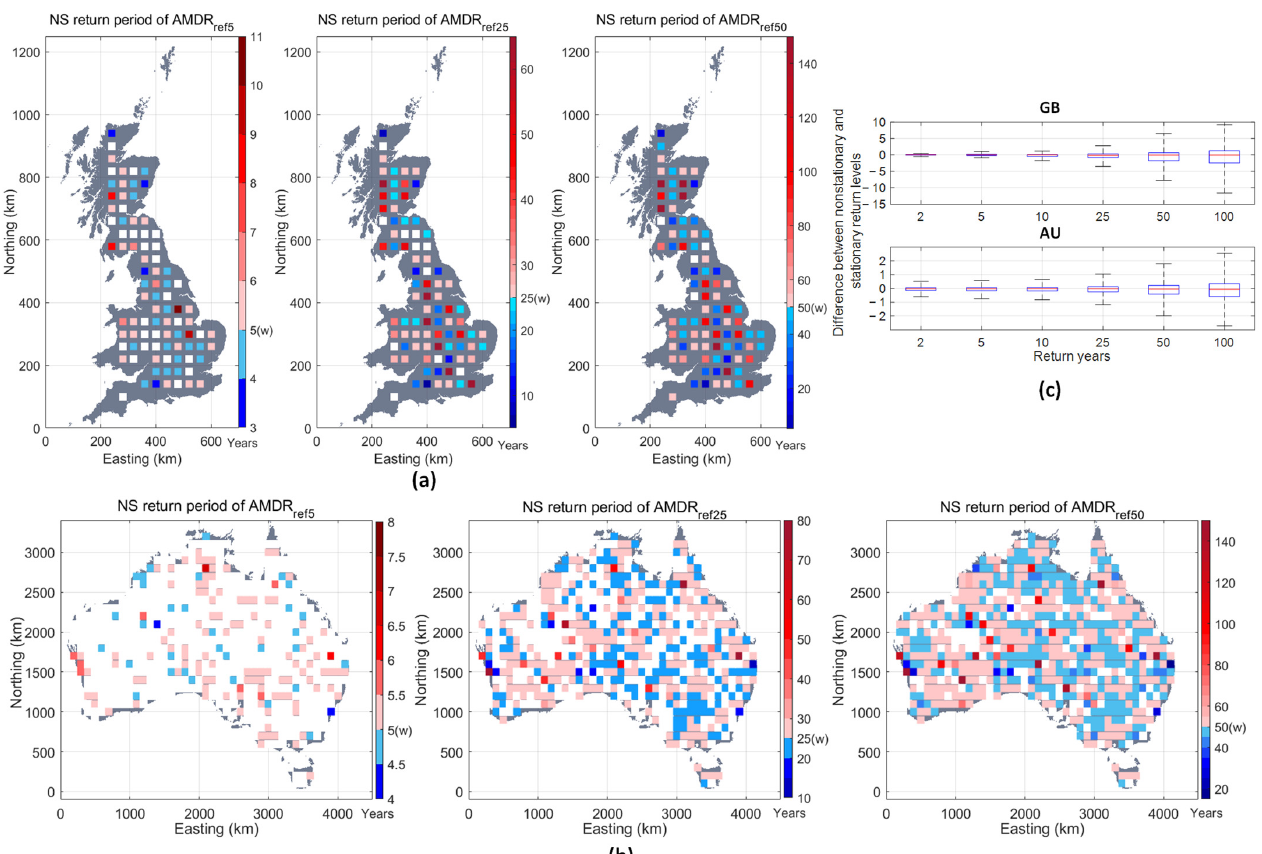
Figure 7. Nonstationary return periods corresponding to the return levels estimated by the stationary model and the spatial distribution referring to 1-in-5 years, 1-in-25 years and 1-in-50 years in GB ( a ) and AU ( b ). An overall comparison between the nonstationary and stationary return levels corresponding to the same return year is presented as a boxplot in ( c ) where the upper panel shows the GB case and the lower shows the AU case. Noted that “w” in the colour bar indicates the colour white which means there is no difference between stationary and nonstationary return